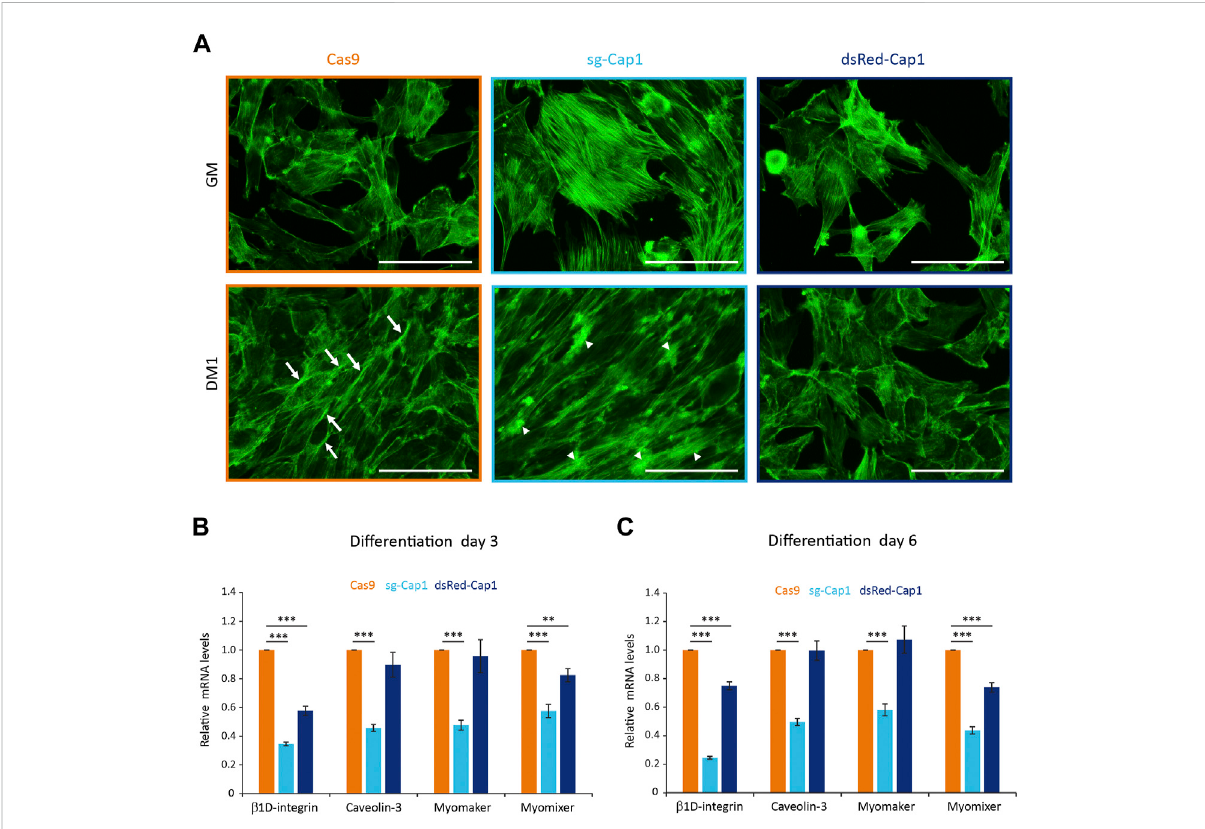
FIGURE 4 Disturbance of the early cortical actin rearrangement and expression of pro-fusion molecules upon changes in CAP1 expression. (A) Cas9 control, sg-Cap1 and dsRed-Cap1 cells were cultured in growth medium (GM) or differentiation medium (DM1; day 1 of differentiation) and fi xed and stained to detect F-actin using phalloidin. Aligned Cas9 control cells (lower panel) show longitudinal actin fi ber accumulation at sites of contact (arrows), whereas Cap1 knockout cells (sg-Cap1, middle-lower panel) exhibit mislocalized, thickened actin patches (arrowheads). Alignment and cortical actin fi bers are absent in dsRed-Cap1 cells (last panel). Scale bar, 100 μ m. (B,C) The mRNAs for ß1D-integrin , Caveolin-3 , Myomaker , and Myomixer were quanti fi ed by qRT-PCR and normalized to a set of housekeeping mRNAs at day 3 (B) and day 6 (C) of differentiation. Error bars , SEM ( n = 3); ** p < 0.01, *** p < 0.001 (Student ’ s t